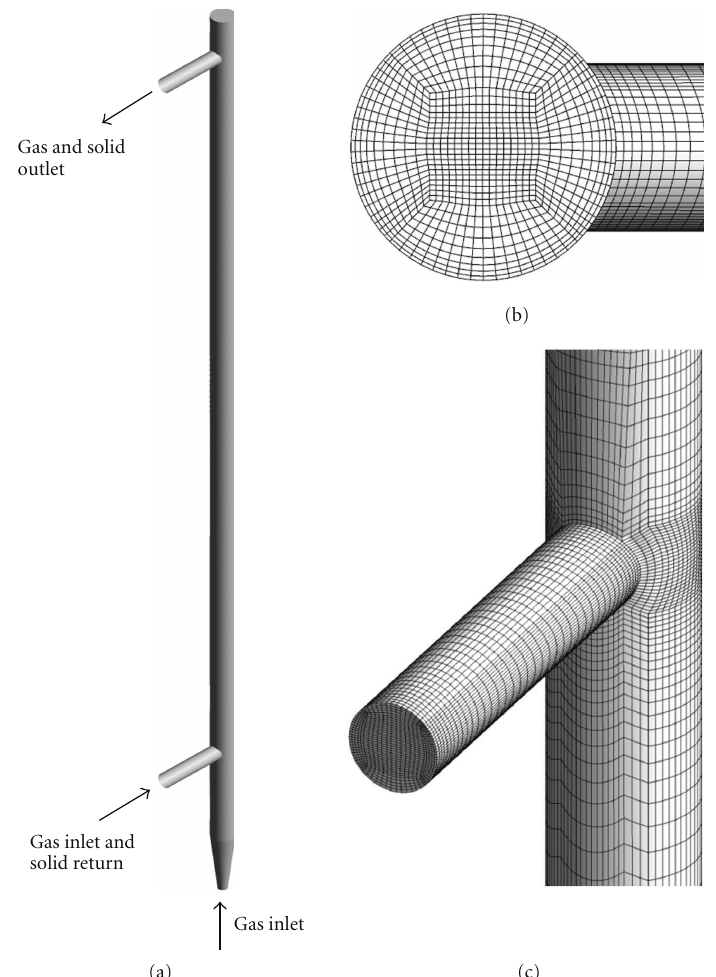
Figure 2: Details of (a) the generated geometry, (b) numerical mesh of the top section, and (c) numerical mesh of the bottom section of the riser for the CFD simulation.